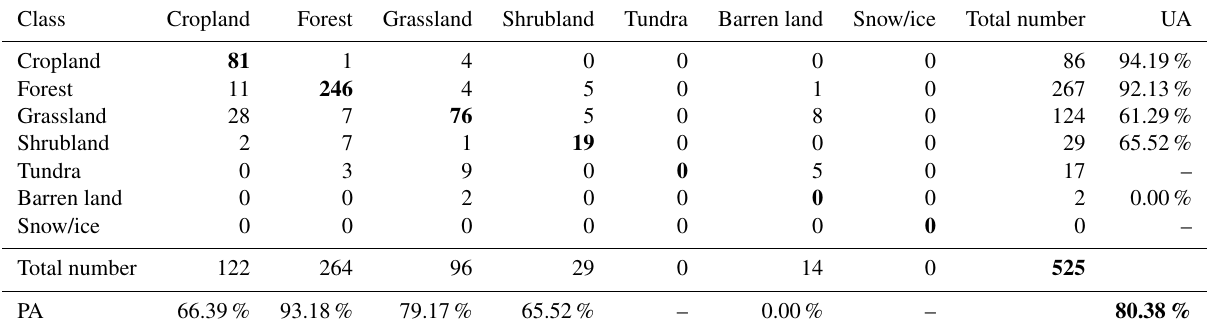
Table 8. Classification accuracy of the ESA-CCI (European Space Agency Climate Change Initiative) land cover product in 2015 based on FLUXNET test samples (overall accuracy = 82.10%; UA denotes user’s accuracy, and PA denotes producer’s accuracy). Bold numbers represent correctly classified